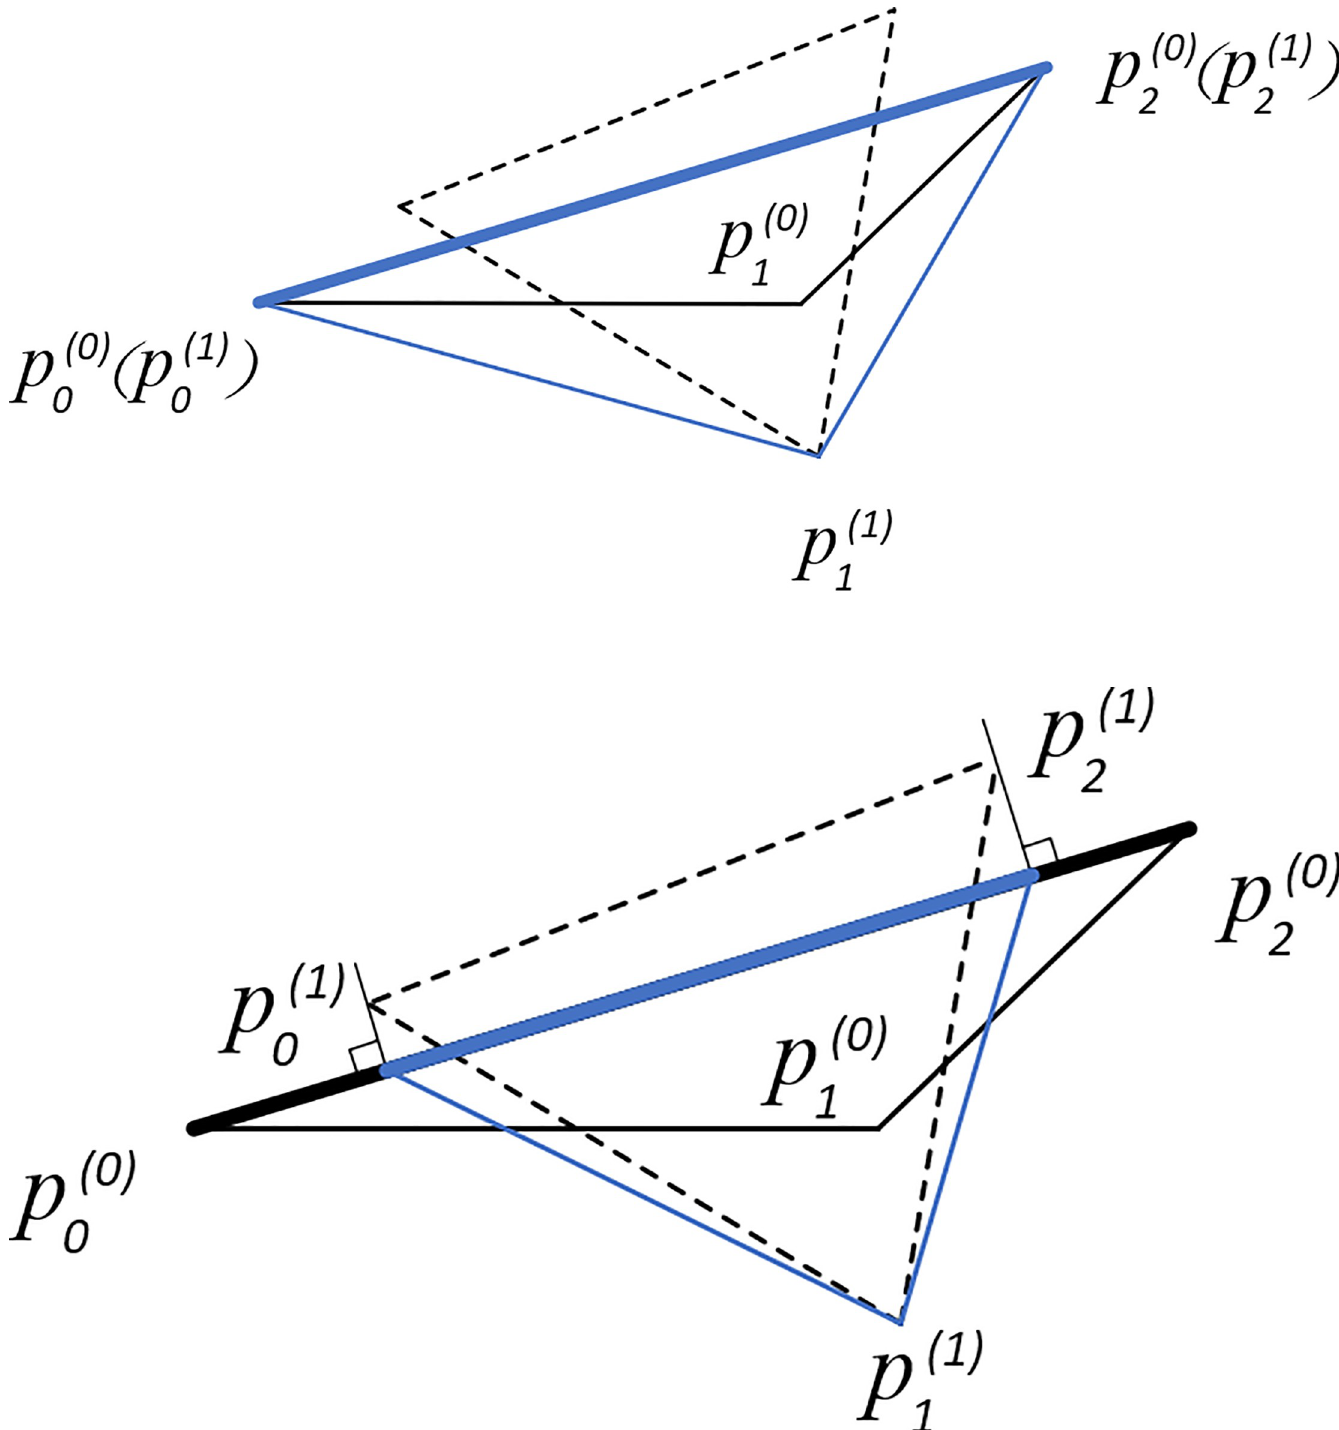
Fig 5. Boundary treatments of the EAS method. a) shows the way of fixing boundary nodes at their original locations; b) shows the way of moving nodes along the direction of boundary edges by projection. Original triangles are in blue solid lines; virtual triangles after smoothing without boundary treatments are in black dotted lines; actual triangles after smoothing considering boundary treatments are in blue solid lines black; and boundary edges are in heavy solid lines.